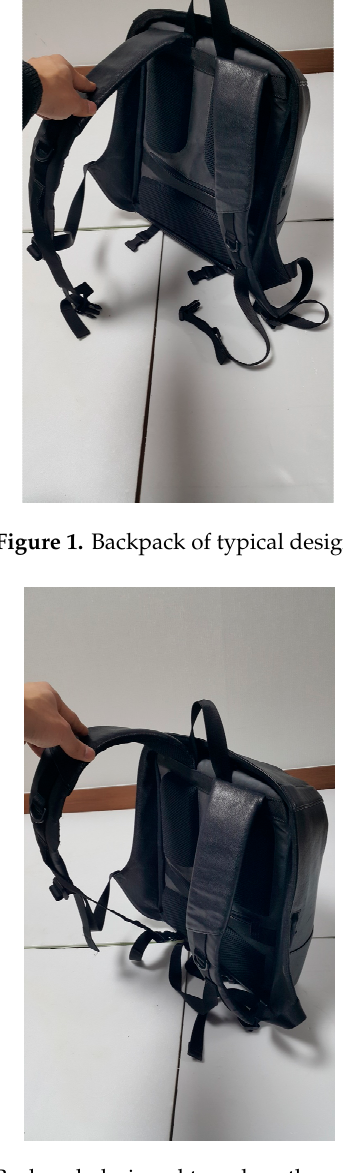
Figure 2. Backpack designed to reduce the moment arm.